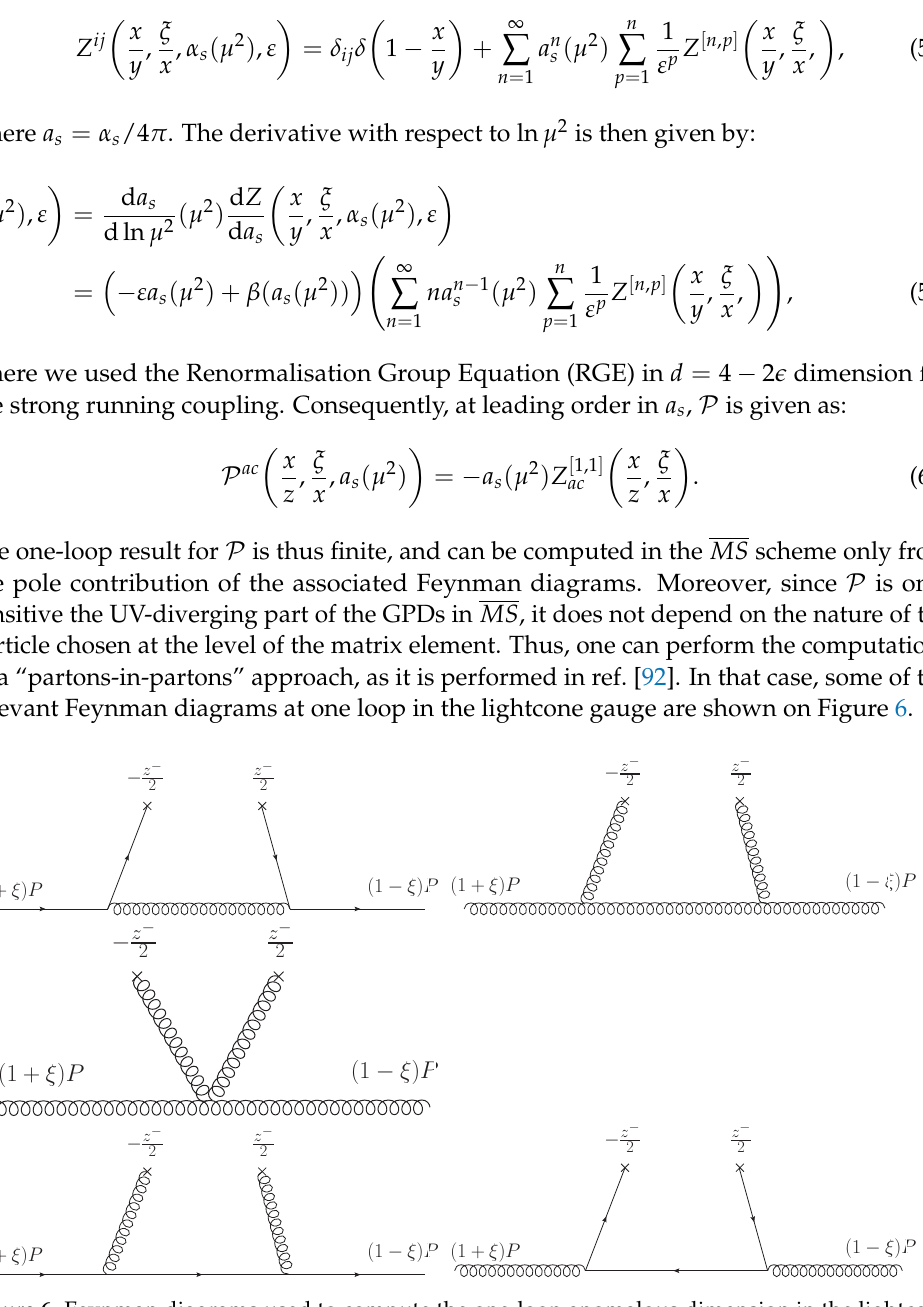
Figure 6. Feynman diagrams used to compute the one-loop anomalous dimension in the lightcone gauge. On the first and second lines, we display non-mixing terms, while the third line display diagrams mixing quark and gluon GPDs. On top of these connected diagrams, disconnected self- energy diagrams need to be added. In covariant gauges, additional contributions come from gluon exchanges with the Wilson